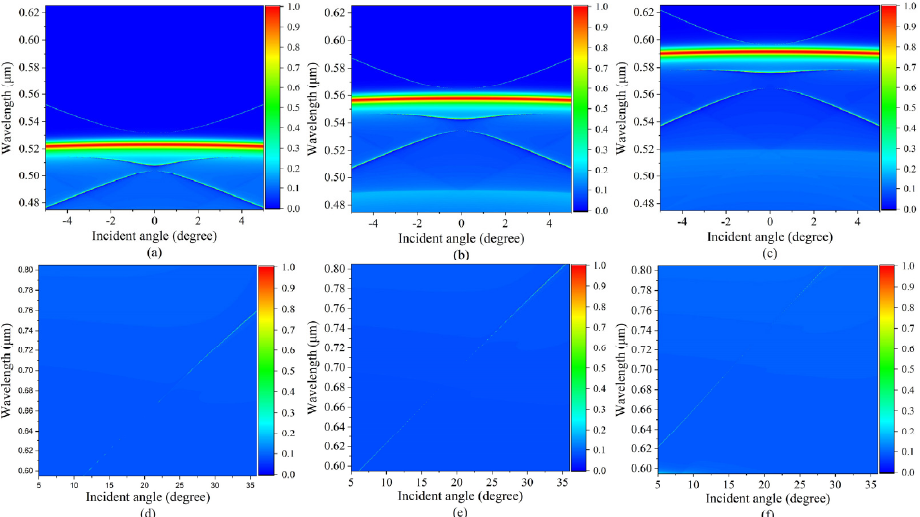
Figure 6. Re fl ectance spectra of the metasurface around at Γ BICs with la tt ice constant ( a ) a = 0.316 µm, ( b ) a = 0.336 µm, and ( c ) a = 0.356 µm, respectively, and around o ff Γ BIC with la tt ice constant ( b ) a = 0.336 µ m, and ( c ) a = 0.356 µ m, respectively, and around off Γ BIC with lattice constant ( d ) a = 0.316 µm, ( e ) a = 0.336 µm, and ( f ) a = 0.356 µm, respectively. L 1 = L 2 = 0.2 µm, and W 1 = W 2 = ( d ) a = 0.316 µ m, ( e ) a = 0.336 µ m, and ( f ) a = 0.356 µ m, respectively. L 1 = L 2 = 0.2 µ m, and 0.1 µm. W 1 = W 2 = 0.1 µ